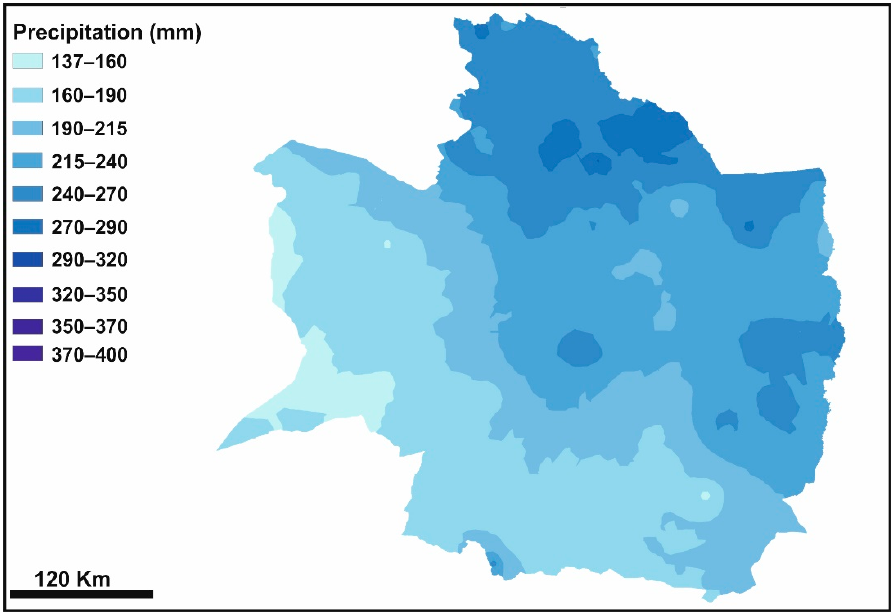
Figure 2. Interpolated annual precipitation map based on the IDW method.